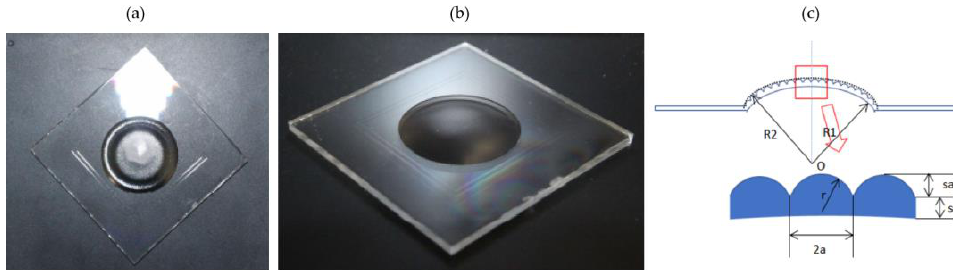
Figure 1. ( a , b ) The structure of the sample at different angles, MLAs on the top of the surface. ( c ) The designed structure of the sample, the MLA parameters shown in the zoomed image.